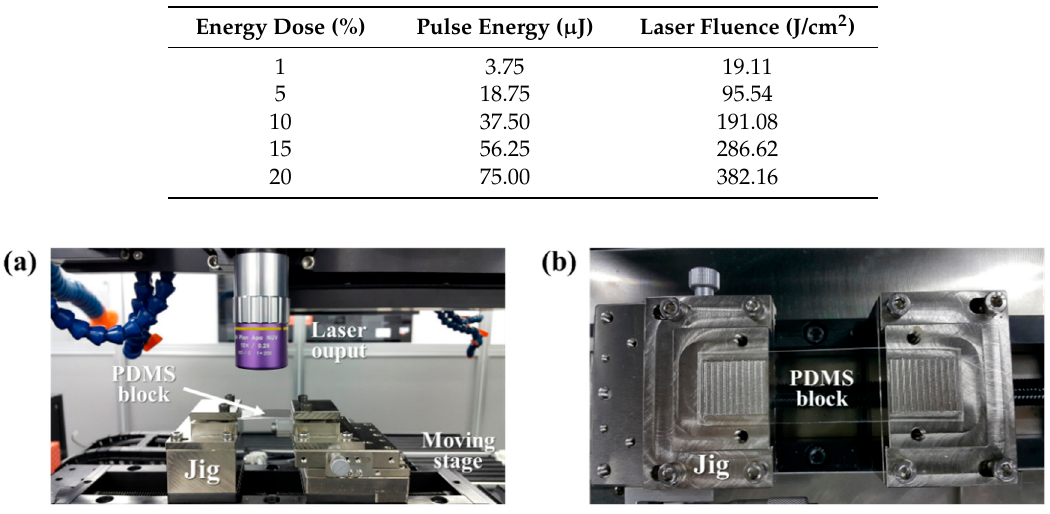
Table 1. Summary of the laser micro-scribing parameter at various laser intensities in terms of energy doses.